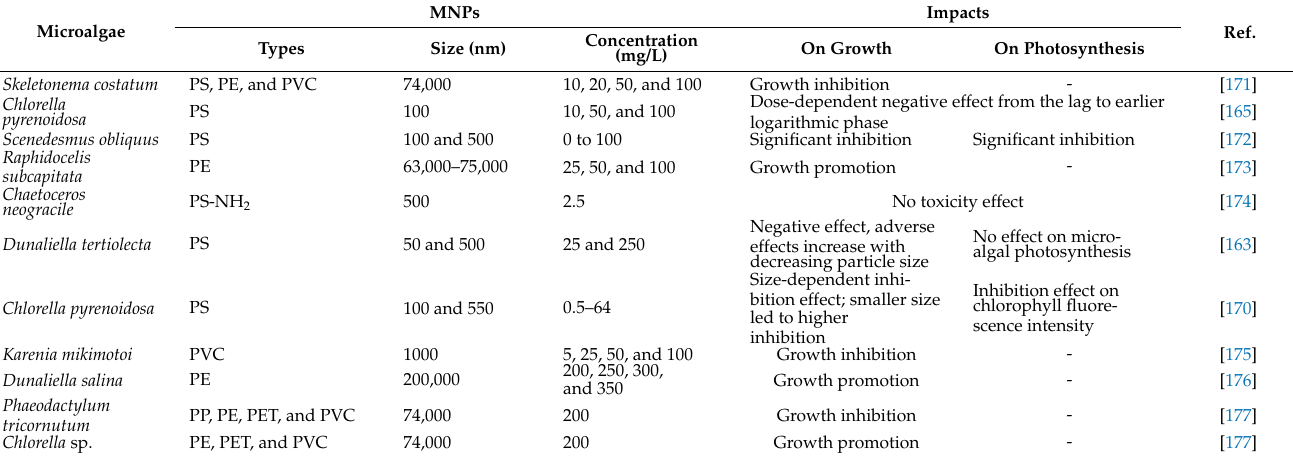
Table 2. Previous reports on the impact of micro-/nanoplastics (MNPs) on the growth and photosyn- thetic activity of